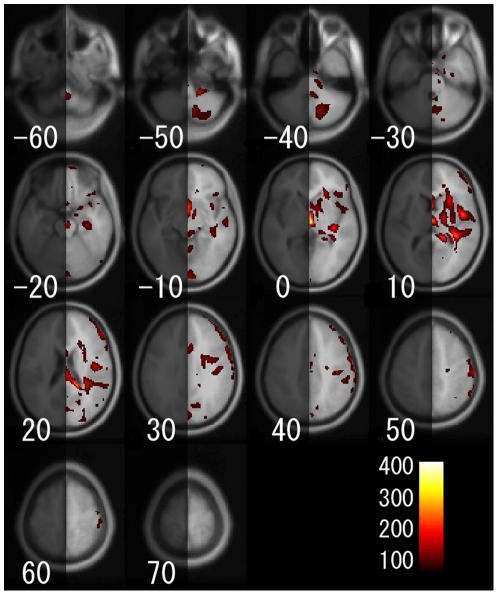
Gray matter regions that showed a significant age × hemisphere interaction on regional gray matter volume.Details are the same as in Figure 4.